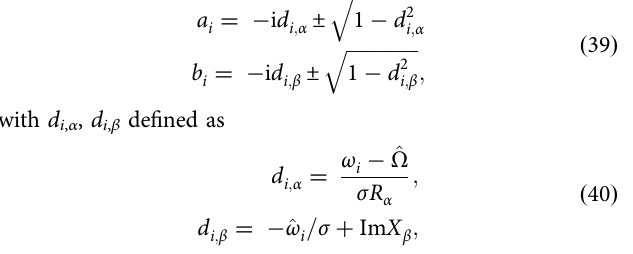
Fig. 7 The desynchronization transition. The evolution of the complex order parameter X α during the backward synchronization transition is plotted in panel ( a ) as the coupling constant decreases (each σ step is indicated by the colors of different lines). These results have been obtained for a network of N = 500, T max ¼ 10, and Δ σ = 0.03. During this backward transition, the onset of the rhythmic phase at σ ? S and the onset of the incoherent phase at σ c are indicated. The onset of the rhythmic phase corresponds exactly to the emergence of a non-zero oscillation frequency Ω E , as shown in panel ( b ).